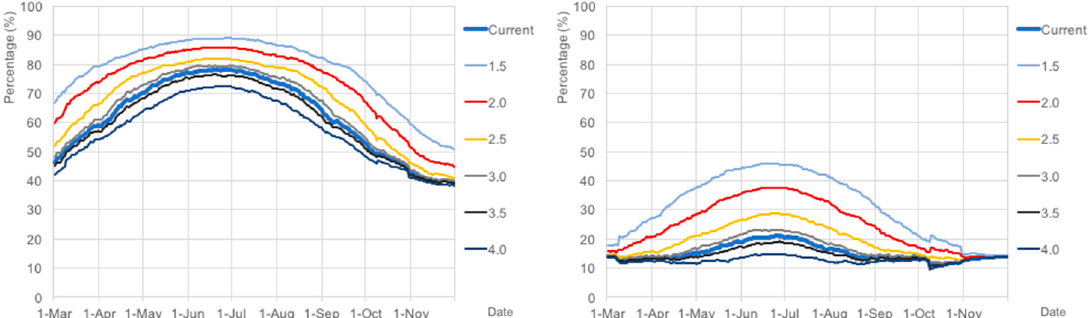
Figure 5. Percentages of ground-level surface with direct sunlight for three or more hours ( left ) and six or more hours ( right ) from March to November for study site E with the current FAR (3.235) in comparison with tested FARs (1.5, 2.0, 2.5, 3.0, 3.5, and 4.0).